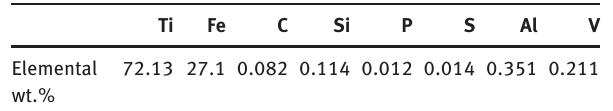
Figure 1: Equilibrium phase diagram of Fe-Ti [22].